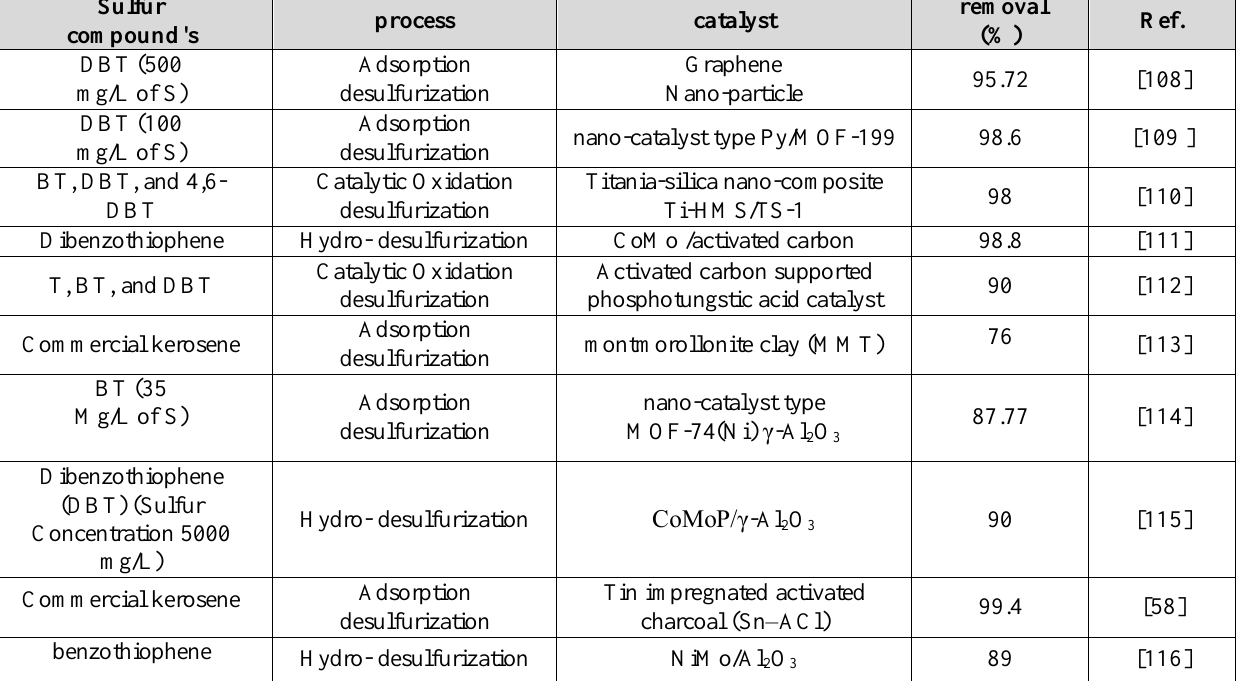
Table 2: Summary for catalysis desulfurization of the sulfur